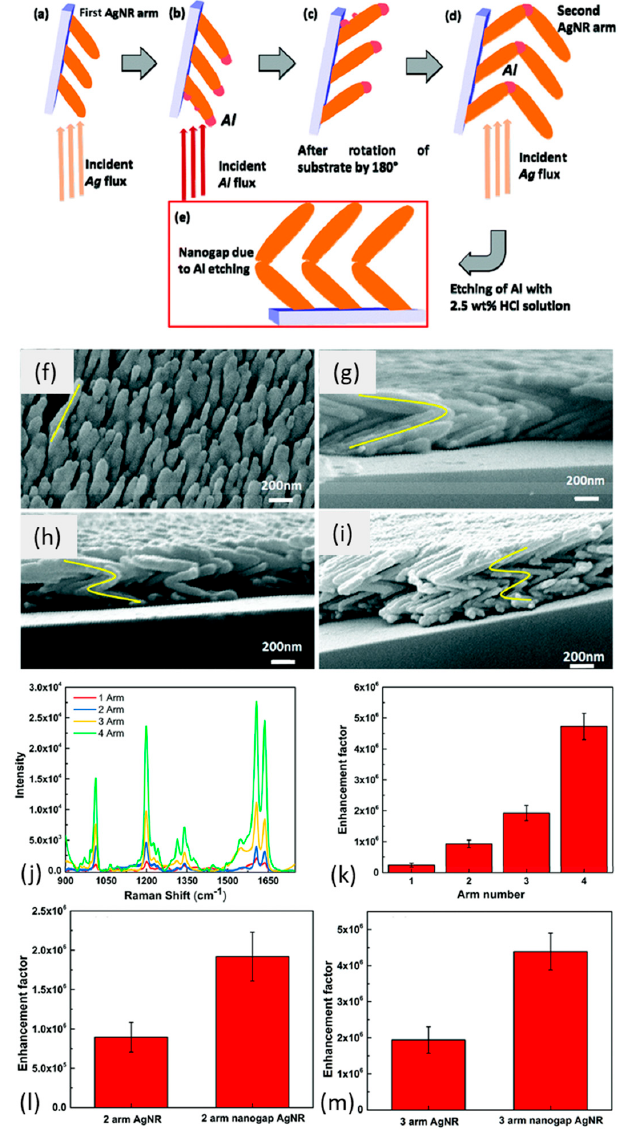
Figure 4. ( a – e ) An illustration of the fabrication of nano-porous zig-zag AgNR arrays; SEM images of zig-zag AgNR arrays on silicon substrate with: ( f ) 1 arm; ( g ) 2 arms; ( h ) 3 arms; and ( i ) 4 arms, respectively. Yellow lines show the approximate arm positions. ( j ) BPE SERS spectra (0.1 mM) acquired over zig-zag AgNR arrays with different numbers of arms. ( k ) Enhancement factor for the BPE SERS peak at 1200 cm − 1 as a function of arm number. Calculated enhancement factor values for ( l ) 2-arm zig-zag AgNRs and 3-arm nanogap AgNR arrays and ( m ) 3-arm zig-zag AgNRs and 3-arm nanogap AgNR arrays. Reproduced with permission from [64].